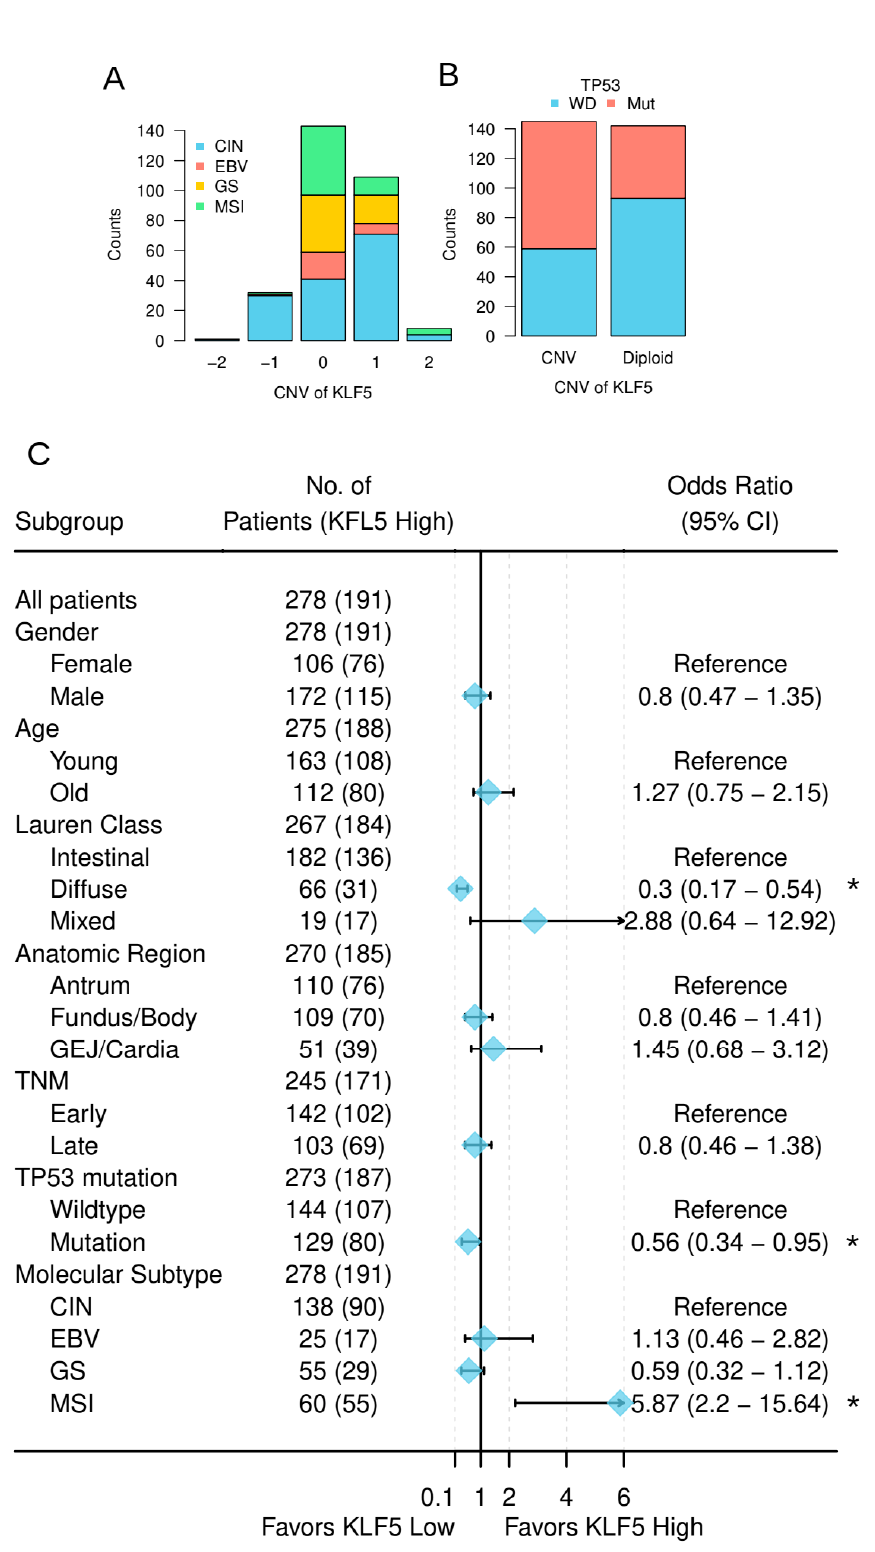
Figure 4. Relationship between KLF5 and characteristics of gastric cancer from TCGA cohort. ( A ) Relationship between the CNV of KLF5 and the molecular subtypes of gastric cancer (Supplementary Table S1); ( B ) relationship between KLF5 copy number and TP53 mutation status. WD stands for wild-type, Mut stands for mutated (Supplementary Table S2); ( C ) association between KLF5 expression and the clinicopathological features of the patients from TCGA cohort. * p < 0.05.